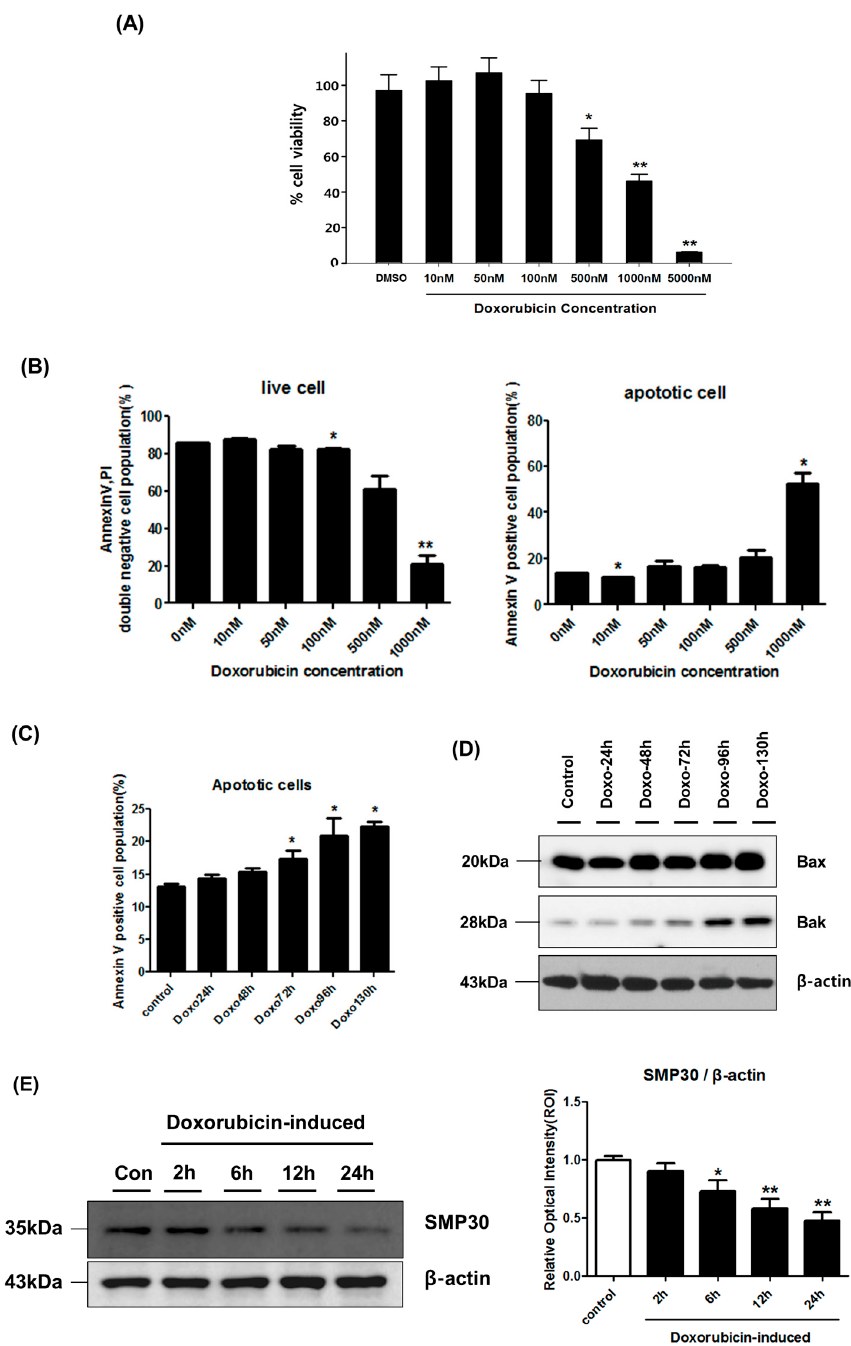
Figure 1. Effects of doxorubicin on hCPC cytotoxicity. ( A ) After treatment of hCPCs with doxorubicin (10, 50, 100, 500, 1000, 5000 nM) for 24 h, the cell viability was examined by MTS assay. * p < 0.05 versus DMSO control; ** p < 0.01 versus DMSO control; ( B ) hCPCs were treated with doxorubicin at various concentrations for 24 h, and the population of live and apoptotic cells were examined by Annexin V/PI assay. Live cells mean Annexin V/PI double negative cell population, while apoptotic cells mean annexin V positive cell population in this graph. * p < 0.05 versus 0nM control; ** p < 0.01 versus 0 nM (DMSO) control; ( C ) To determine doxorubicin-induced apoptosis in hCPCs, Annexin V/PI assay performed in a time-dependent manner. * p < 0.05 versus DMSO treatment control; ( D ) The expression of pro-apoptotic proteins including Bax and Bak was examined. hCPCs were treated with 100 nM doxorubicin for 130 h; ( E ) The expression level of SMP30, a senescence marker protein, was quantified by Western blot. * p < 0.05 versus control; ** p < 0.01 versus control. Data are mean ± SEM, n: total number; hCPCs: human cardiac progenitor cells.